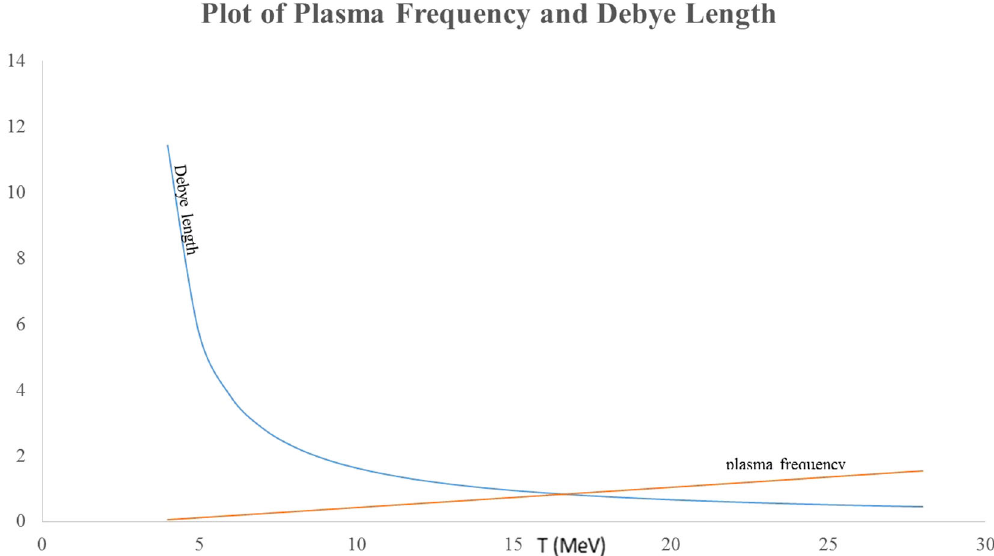
Fig. 4 Debye length and the plasma frequency are plotted as a function of temperature showing that the screening length increases with T . When temperature rises around 16 times the mass of the electron which is around 8 MeV, a phase transition takes